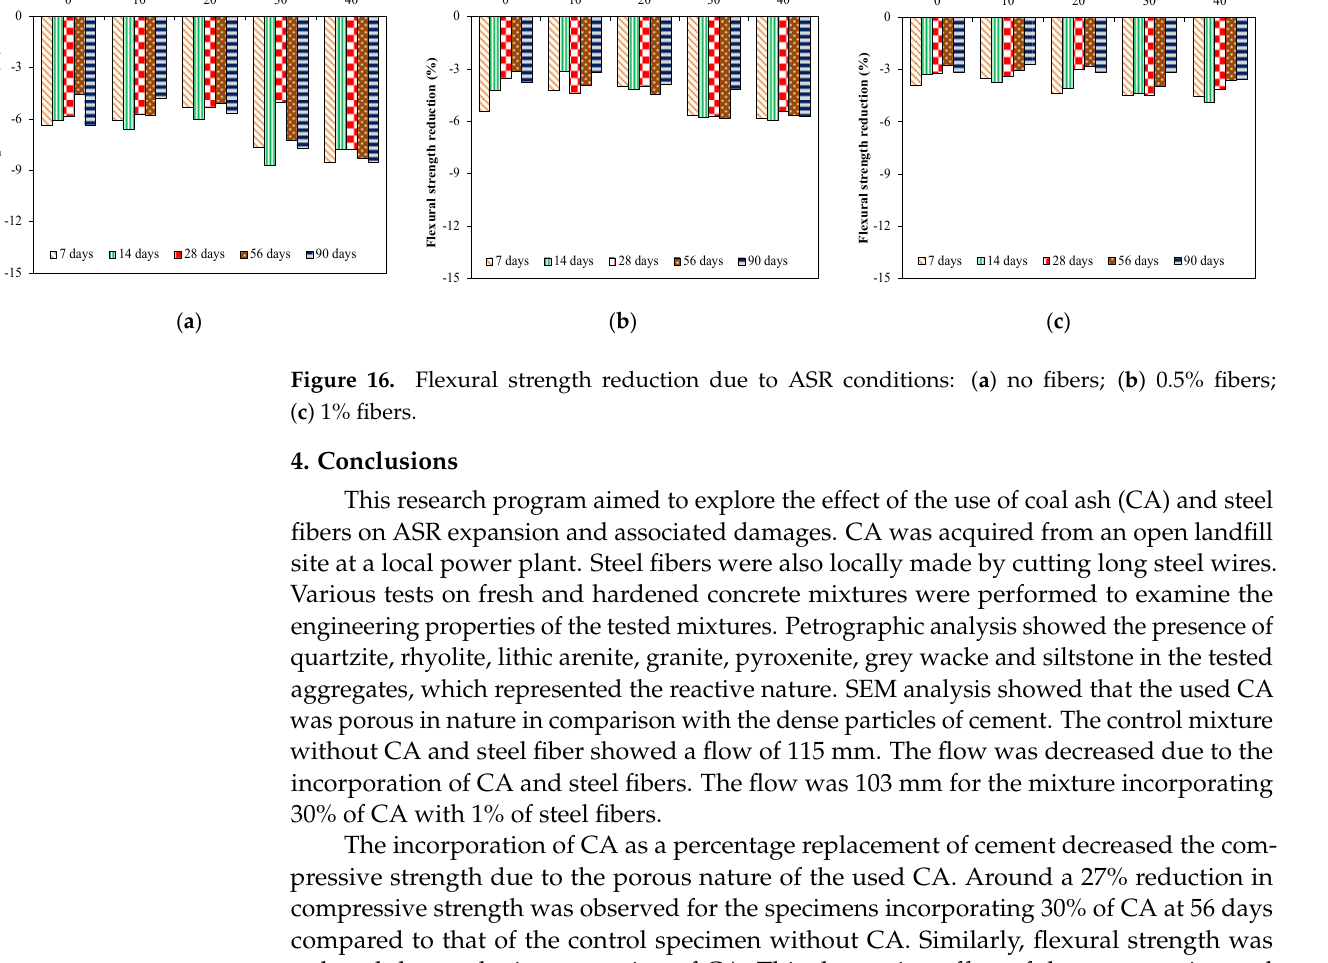
Figure 15. Compressive strength reduction due to ASR conditions: ( a ) no fibers; ( b ) 0.5% fibers; ( c ) 1% fibers.